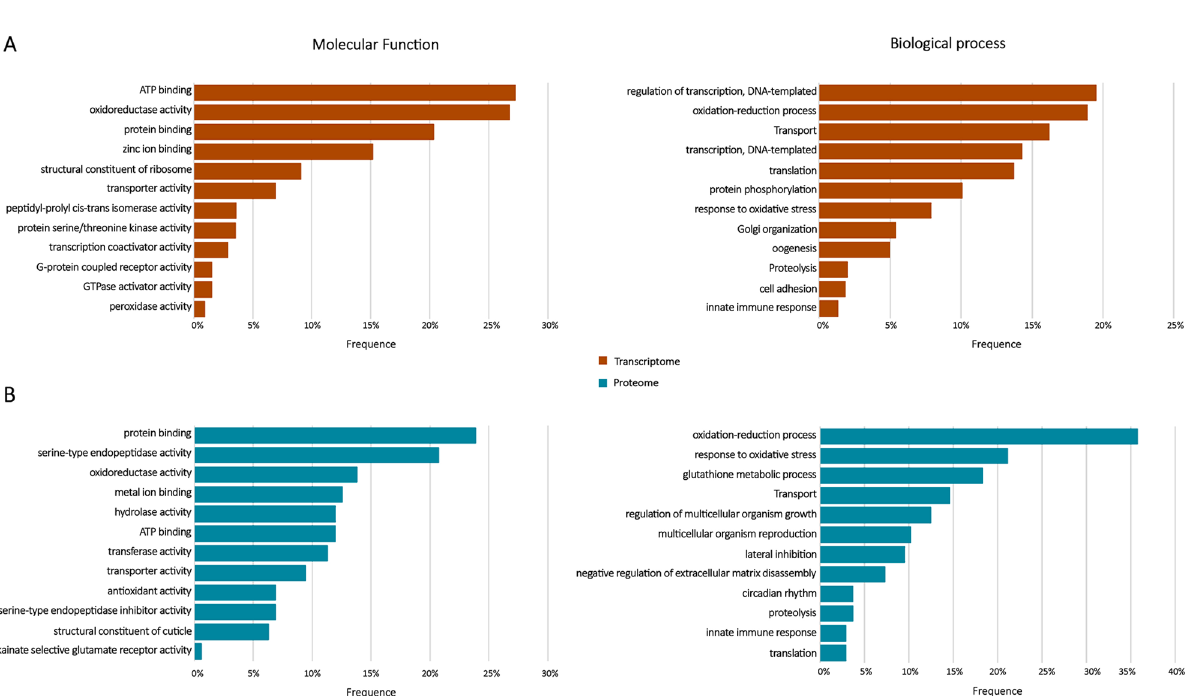
Figure 3. Functional classifications analysis. The Gene Ontology enrichment analysis was performed based on unique sequence homology. ( A ) Transcripts from the integument of pararama and ( B ) bristle proteins were classified into two main categories: molecular function and biological process, each one including 12 functional groups. The figure was drawn using Microsoft Excel version 1.5 (www.micro